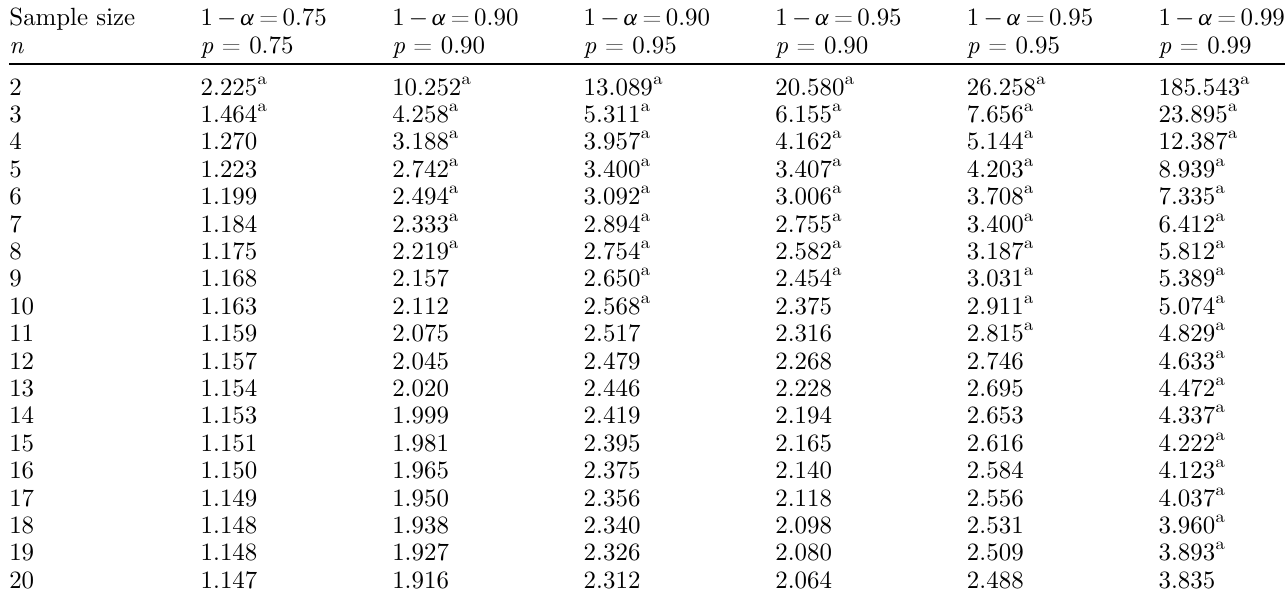
Table 6. Practical factor k